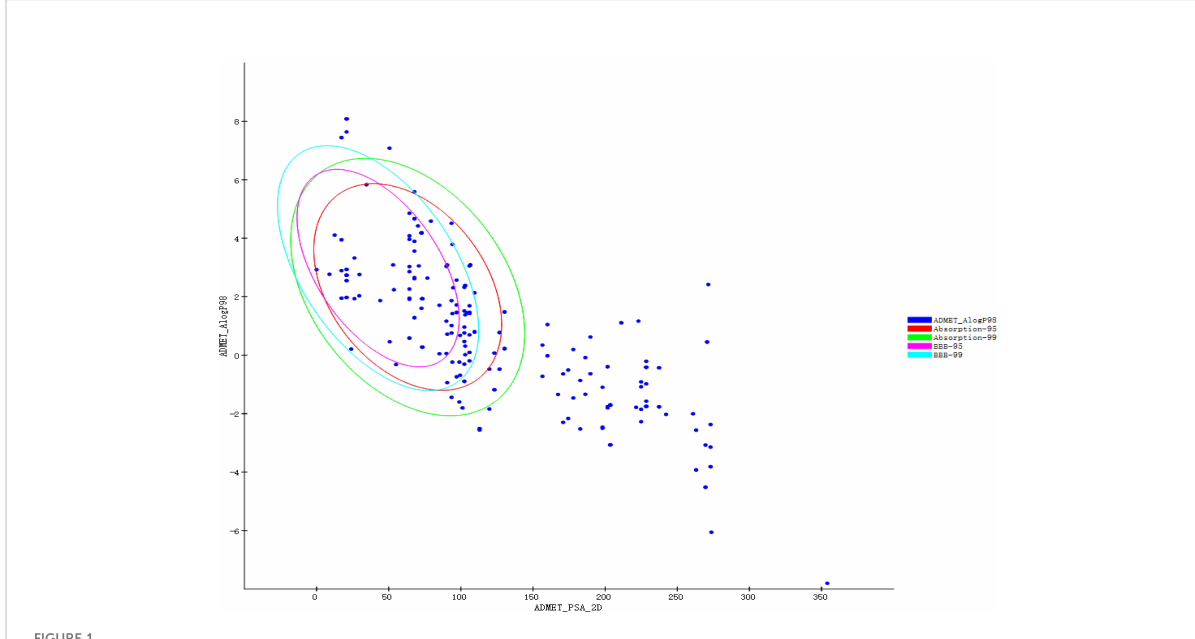
FIGURE 1 ADMET property prediction results of